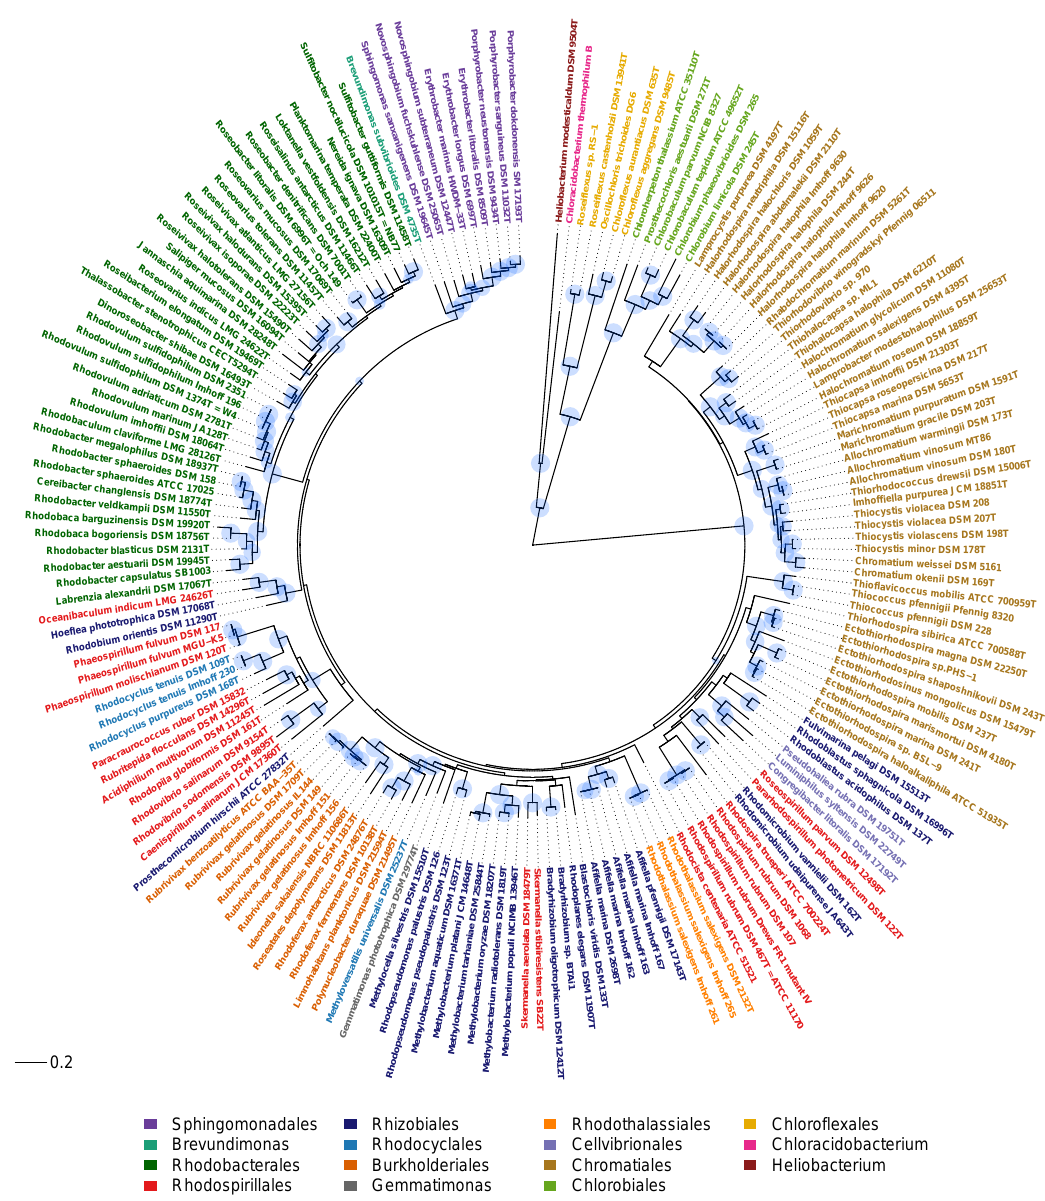
Figure 2. Phylogenetic tree of phototrophic bacteria, according to BchXYZ